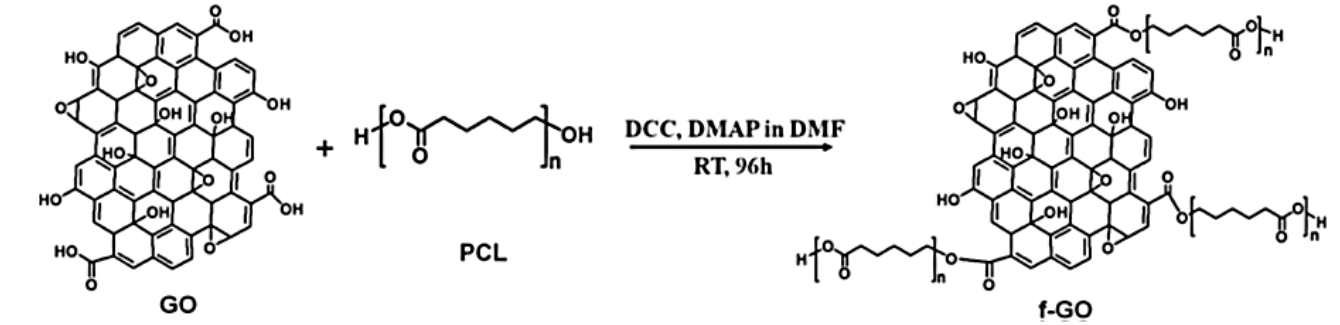
Figure 4. Synthesis scheme of poly(ε-caprolactone) functional graphene oxide [113]. Reproduced with permission from ACS.